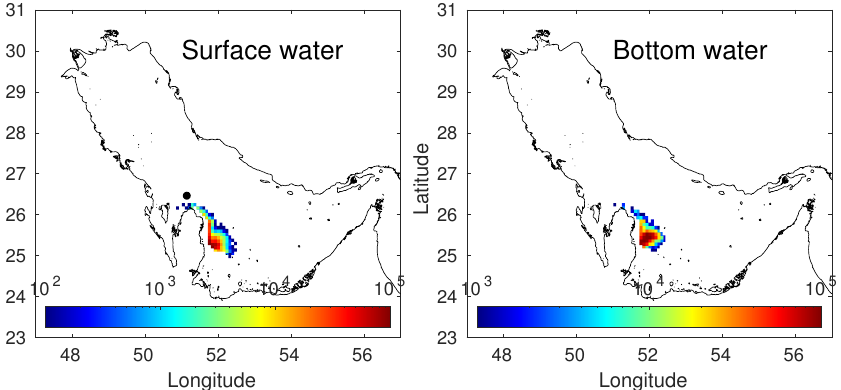
Figure 4. Calculated concentrations in the surface layer (units/m 3 ) and inventory (units/m 2 ) in the bottom water layer for the dissolved pollutant release after 30 days. The black dot in the surface water map indicates the release